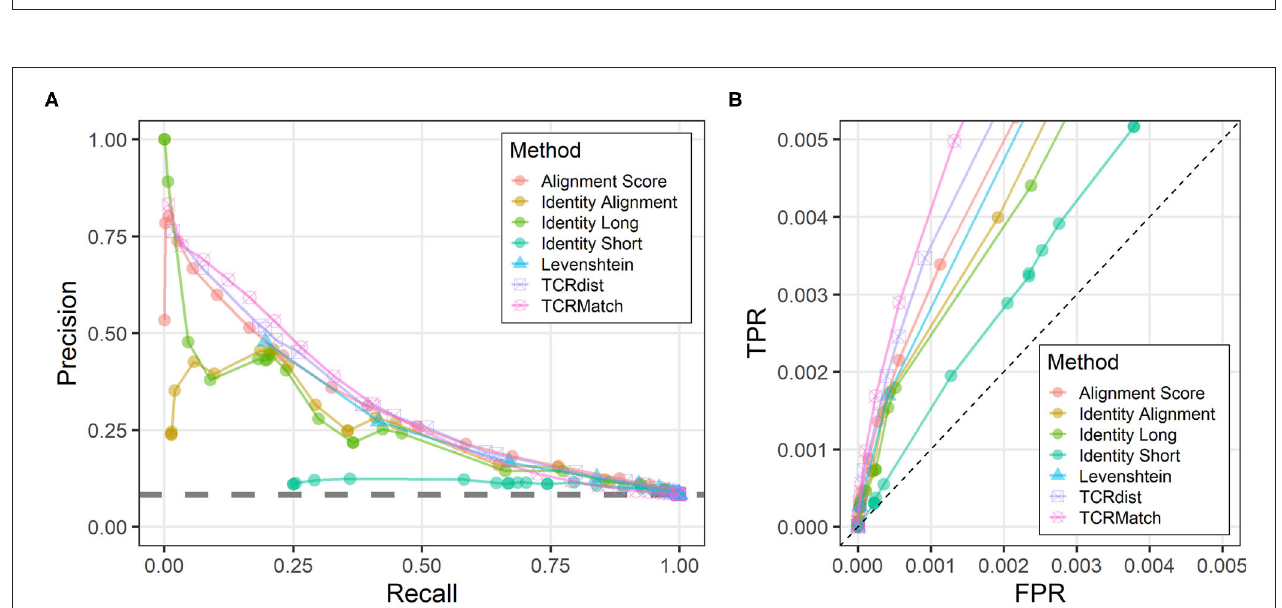
FIGURE 2 | Precision-recall and ROC plots comparing different sequence similarity metrics. (A) Each similarity metric was evaluated at different thresholds for its ability to recall TCR sequences in the IEDB that recognized the same epitope (x-axis) and compared that to the precision at the same threshold (y-axis), which specifies the percentage of match epitopes that were also recognized by the input sequences. The gray dashed line indicates average performance on the randomized IEDB dataset, wherein CDR3 β -epitope pairs were shuffled. (B) All similarity metrics were evaluated for their performance as measured by true positive rate (TPR, y-axis) and false positive rate (FPR, x-axis). The axis ranges of 0–0.005 show the differences in performance among similarity metrics at data points where recall < 0.5, as determined from the analysis shown in (A) . The dashed line indicates a random baseline for which TPR = FPR.